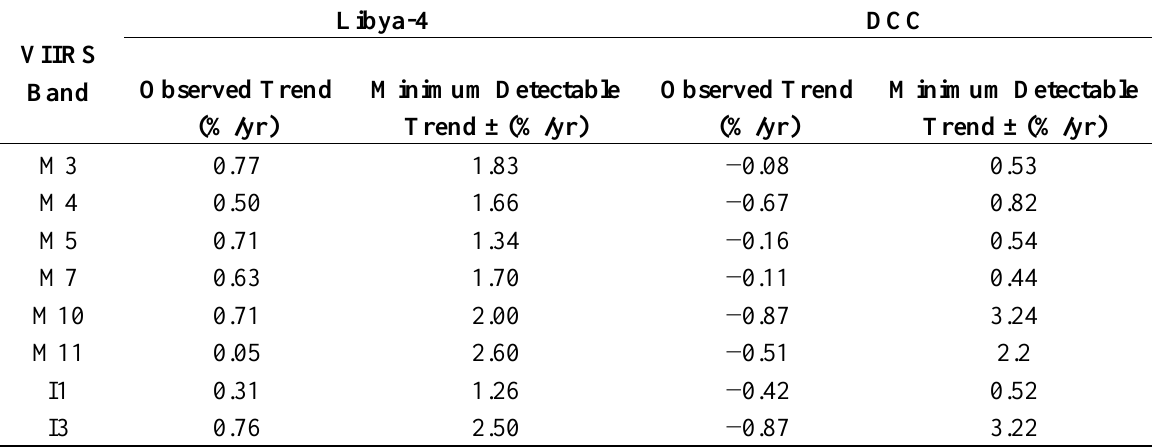
Table 3. Comparison of the observed VIIRS desert and DCC trends (%/yr) with the minimum detectable trend computed at 95% confidence level and with 50% probability using Equation